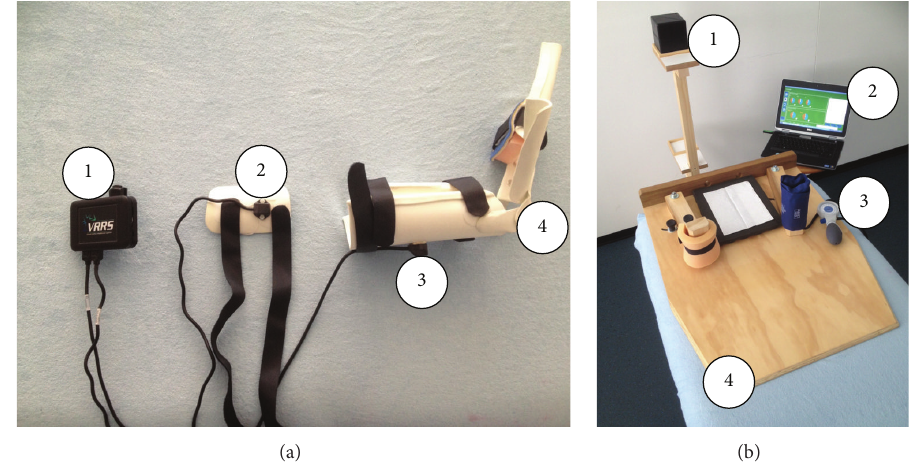
Figure 1: Equipment. (a) (1) Polemus G4 wi-fi hub, (2-3) G4 sensors for arm and forearm respectively, (4) wrist and hand splint. (b) (1) G4 antenna, (2) goniometer software, (3) sphyngomanometer and pressure unit, and (4) wooden positioning device.